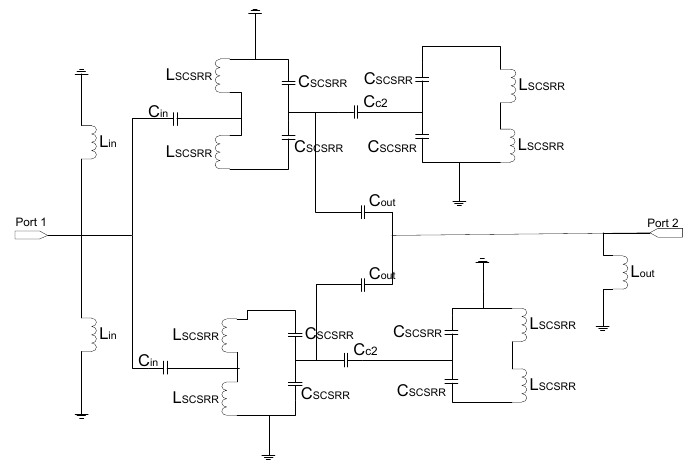
Figure 20. Equivalent circuit model of two frequency side-by-side reverse resonators.